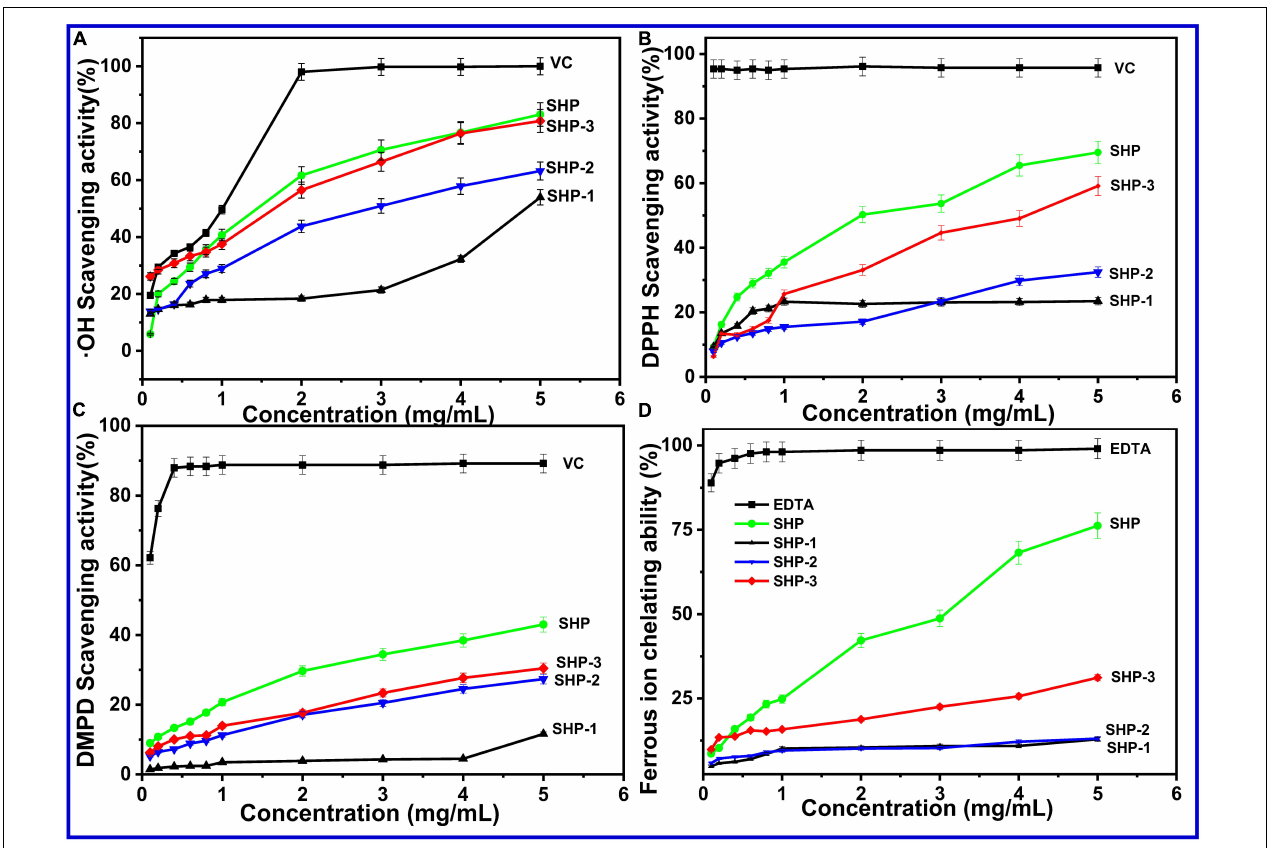
FIGURE 3 | (A) Hydroxyl radical ( · OH) scavenging activity. (B) DPPH-free radical-scavenging assay. (C) DMPD radical-scavenging activity. (D) Ferrous ion chelating ability of SHP-1, SHP-2, SHP-3, and VC.